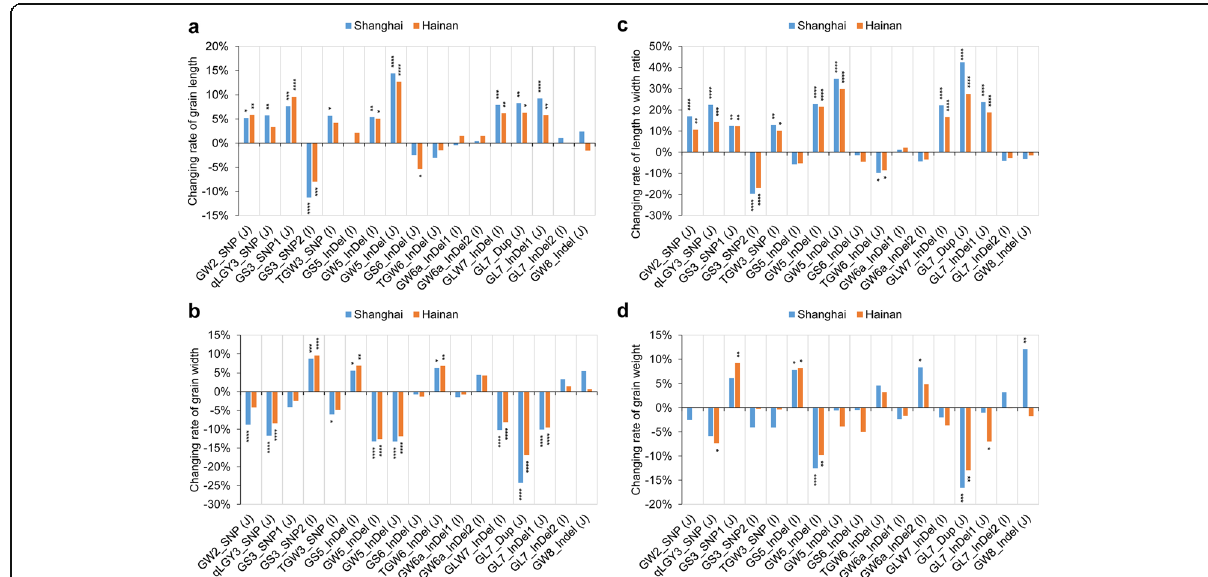
Fig. 5 Contribution of different alleles to four grain-size-related traits. The columns show the relative changing rate of allele 2 (non-NIP-type) exceeding allele 1 (NIP-type) for grain length ( a ), grain width ( b ), length to width ratio ( c ) and grain weight ( d ). The I and J in parentheses represent the indica and japonica subspecies respectively. The values are shown as percentages, and the significance level of the difference between the two alleles of each SNP was calculated by Student ’ s t test. *, **, *** and **** indicate significance at P < 0.05, P < 0.01, P < 0.001 and P < 0.001, respectively